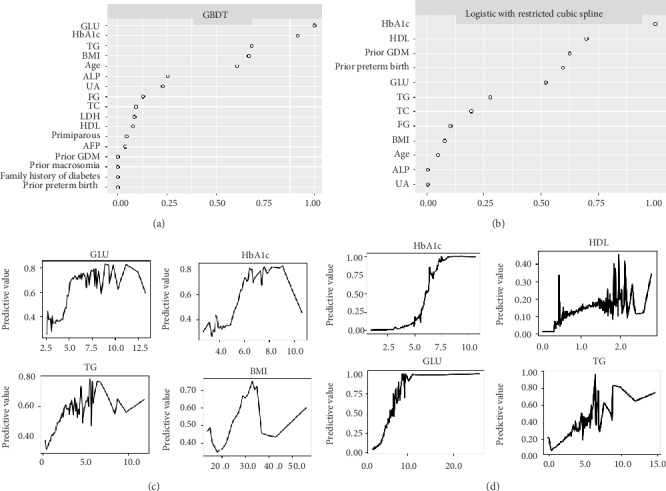
Contribution of the predictor variables in GBDT and the logistic regression model. (a) Importance of the predictor variables in the GBDT model in the validation cohort. (b) Importance of the predictor variables in the logistic model with restricted cubic spline in the validation cohort. (c) Partial plot of the effects of fasting blood glucose (GLU, mmol/L), glycosylated hemoglobin (HbA1c, %), triglyceride (TG, mmol/L), and maternal BMI (kg/m2) on the risk of GDM across different values in the GBDT model. (d) Partial plot of the effect of glycosylated hemoglobin (HbA1c, %), high-density lipoprotein (HDL, mmol/L), fasting blood glucose (GLU, mmol/L), and triglyceride (TG, mmol/L) on the risk of GDM across different values in the logistic model with restricted cubic spline.